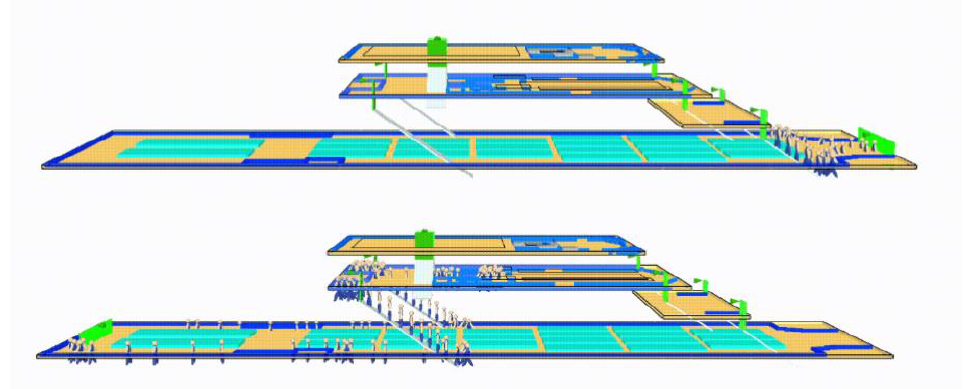
Figure 8. Examples of evacuation simulation. Evacuation took 89 s in the bow direction ( above ) and took 142 s in the stern direction ( below ).